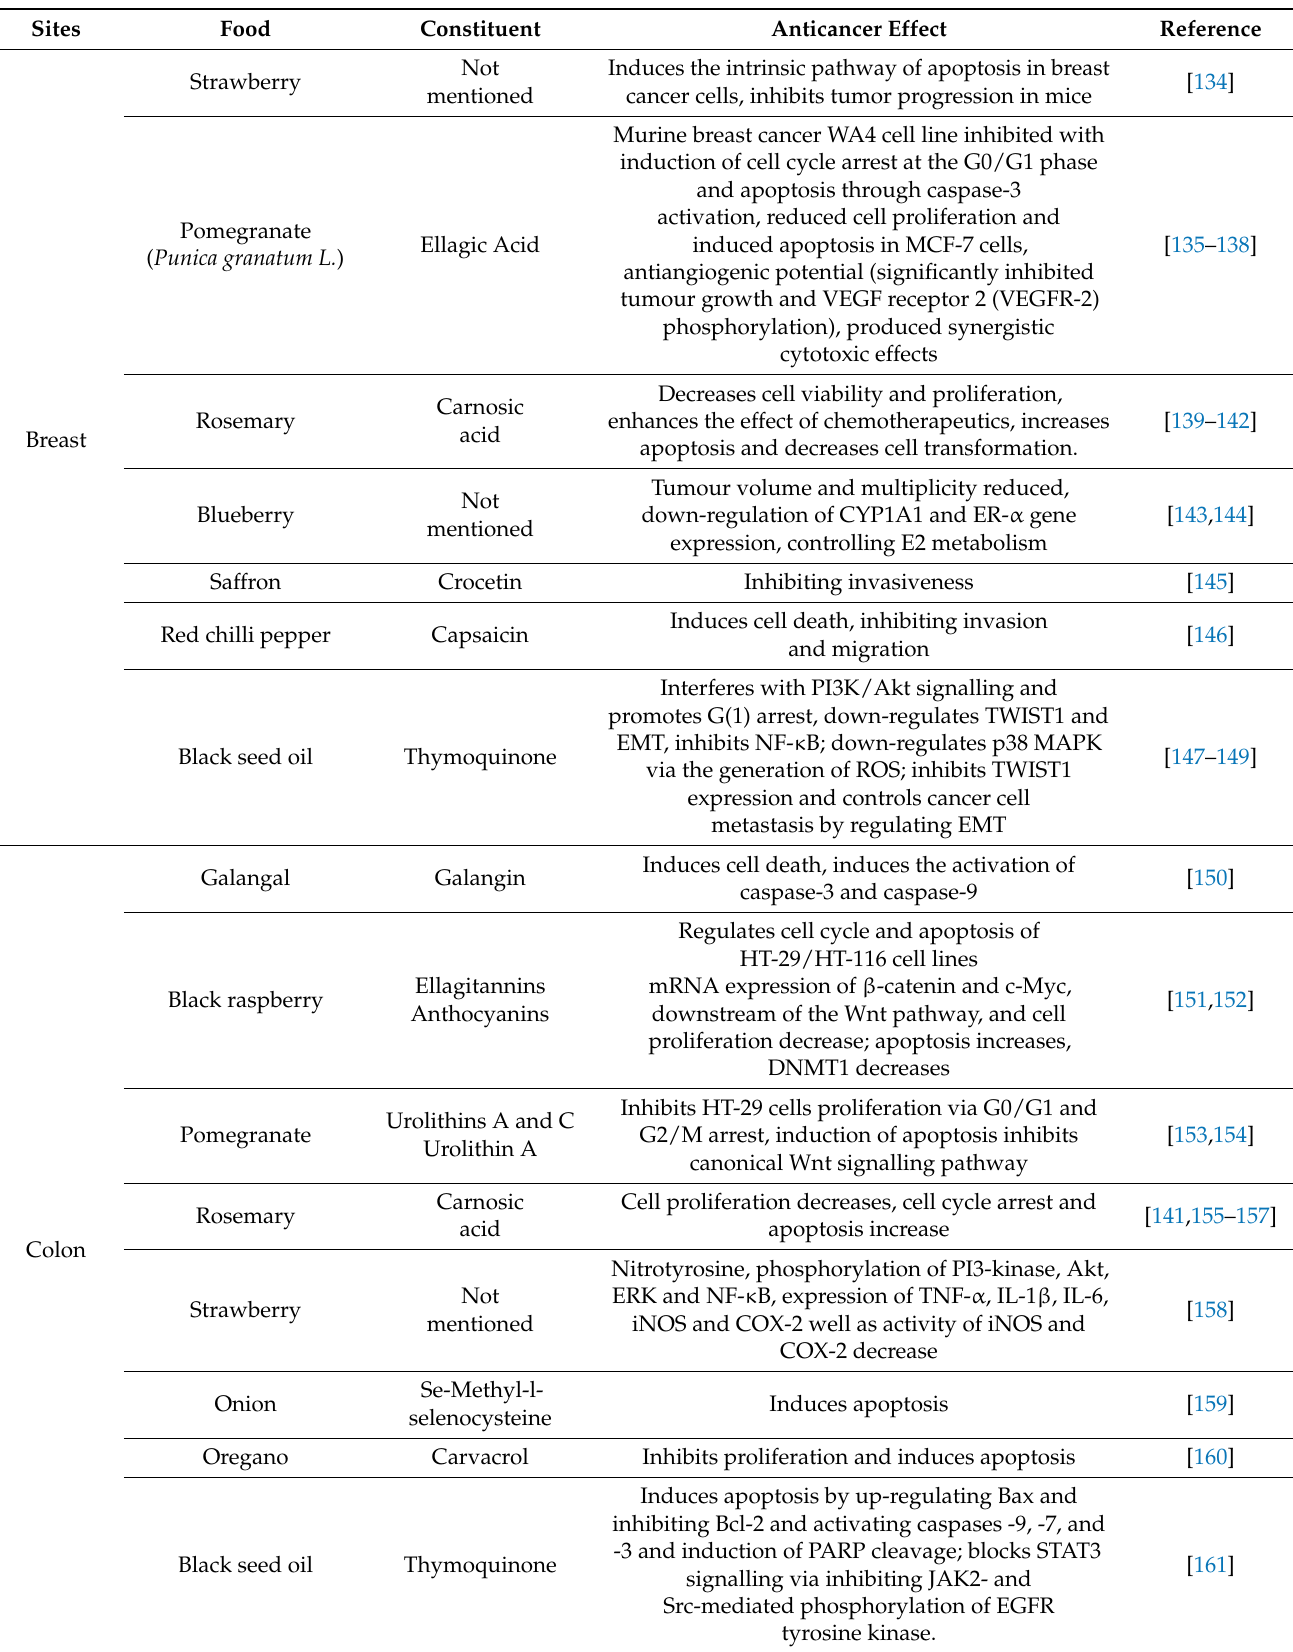
Table 2. Anticarcinogenic Food